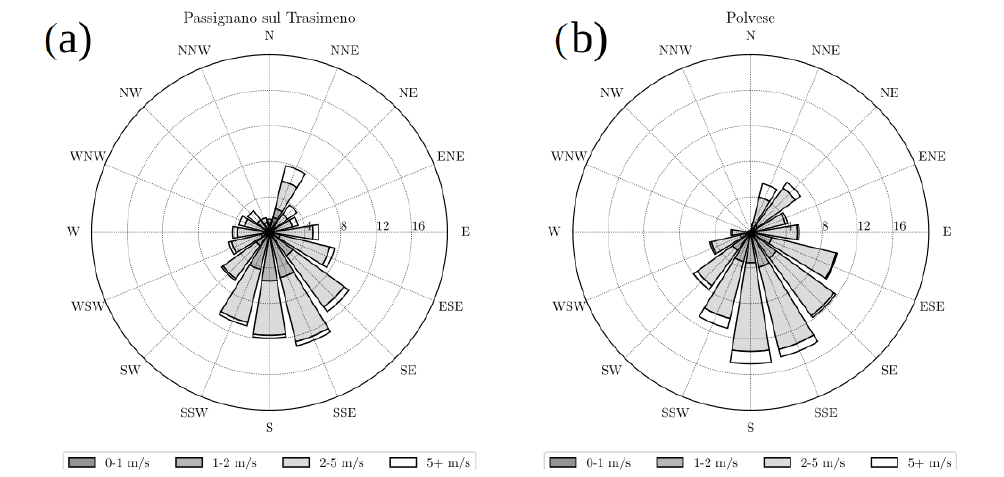
Figure 3. Ten meters wind rose at the two different weather stations in the lake area (black circles in Figure 1): ( a ) Passignano sul Trasimeno; ( b ) Polvese. Radial distance and shading indicate the percentage of days with wind direction in the sector and wind speed intervals, respectively.